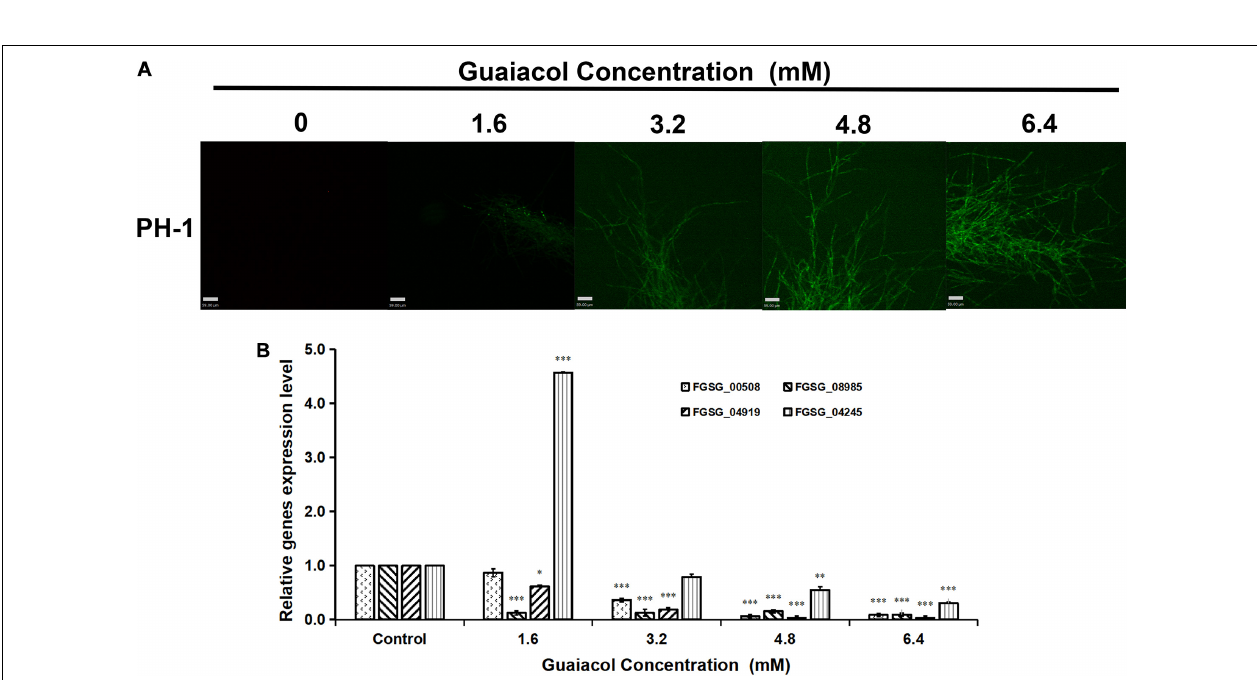
FIGURE 6 | Guaiacol treatment affects intracellular Ca 2 + concentration. (A) Hyphae treated with guaiacol at 0, 1.6, 3.2, 4.8, and 6.4 mM for 24 h were incubated with Fluo-3 AM Calcium indicator. Then, the photos were captured under fluorescence confocal microscope. (B) Relative expression of four Ca 2 + -ATPase (PMCA) genes involved in involved in Ca 2 + transport was determined by qRT-PCR. Each treatment has three replicates, ∗ p < 0.05, ∗∗ p < 0.01, and ∗∗∗ p < 0.001. Bar = 59 µ m.